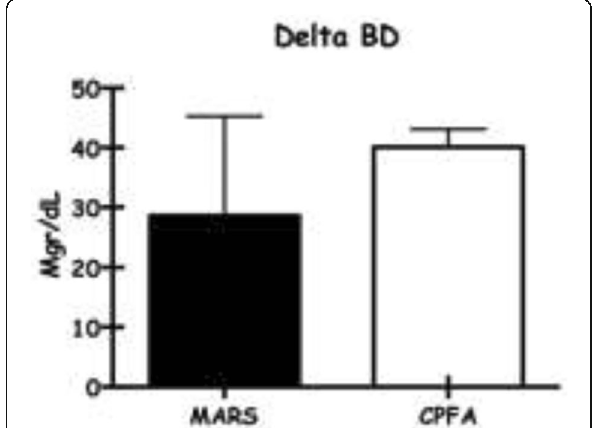
Fig. 1 (abstract 0116). Difference in elimination of direct